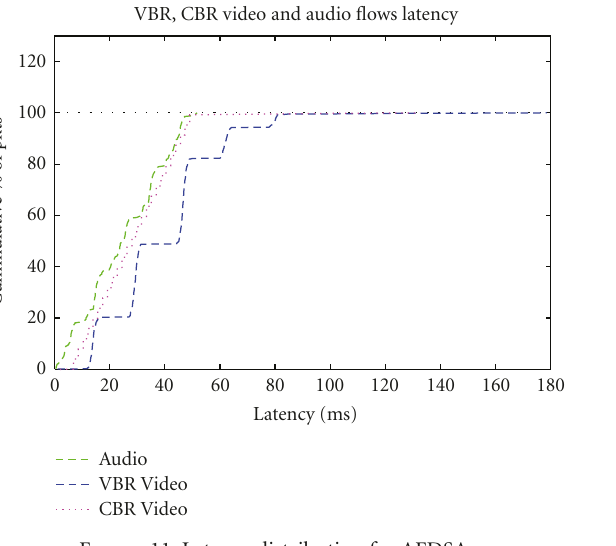
Figure 11: Latency distribution for AFDSA.